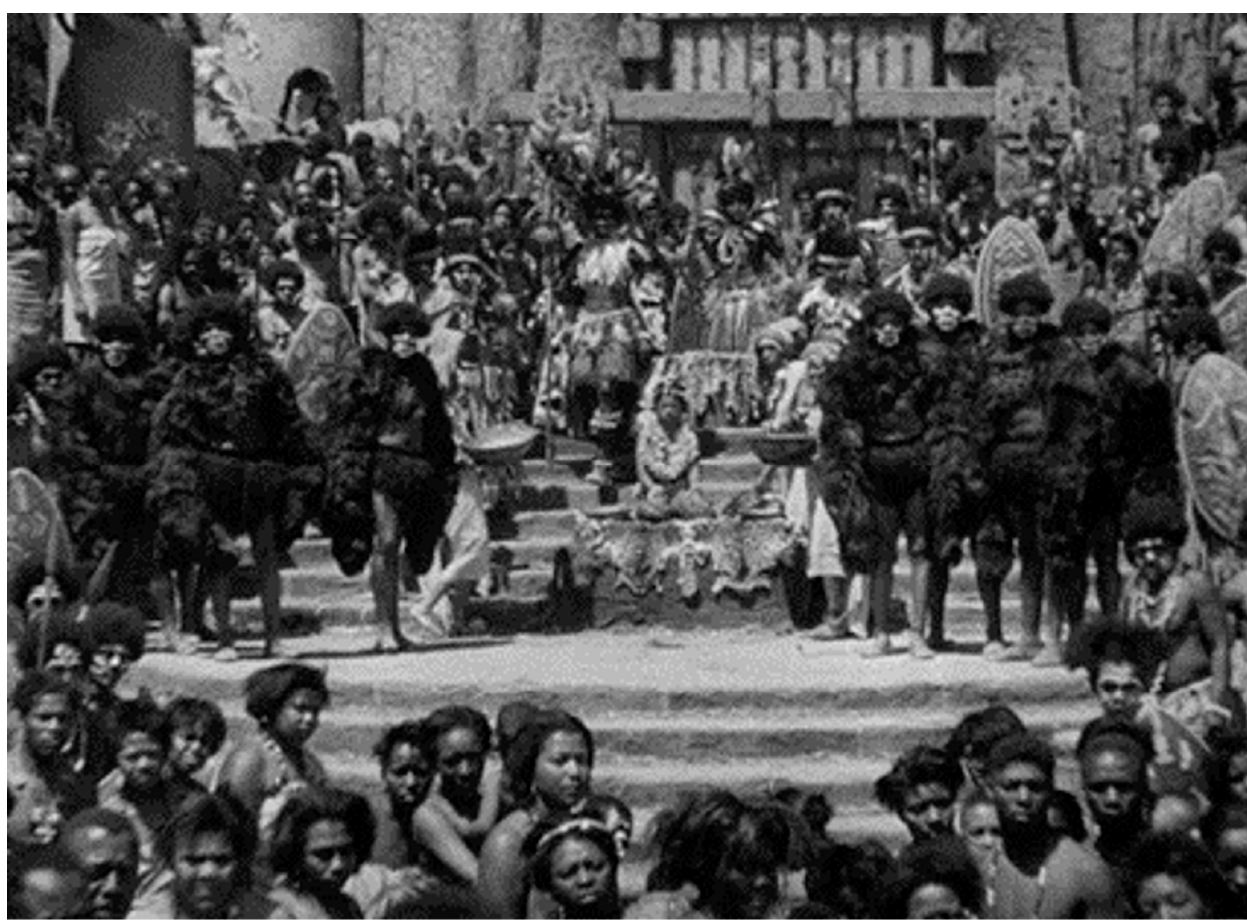
Figure 17. Ritual scene of the settlement on Skull Island where preparations are made for “King Kong’s bride”. Dances in monkey costumes and white paint on their faces. https://lh3.googleusercon-